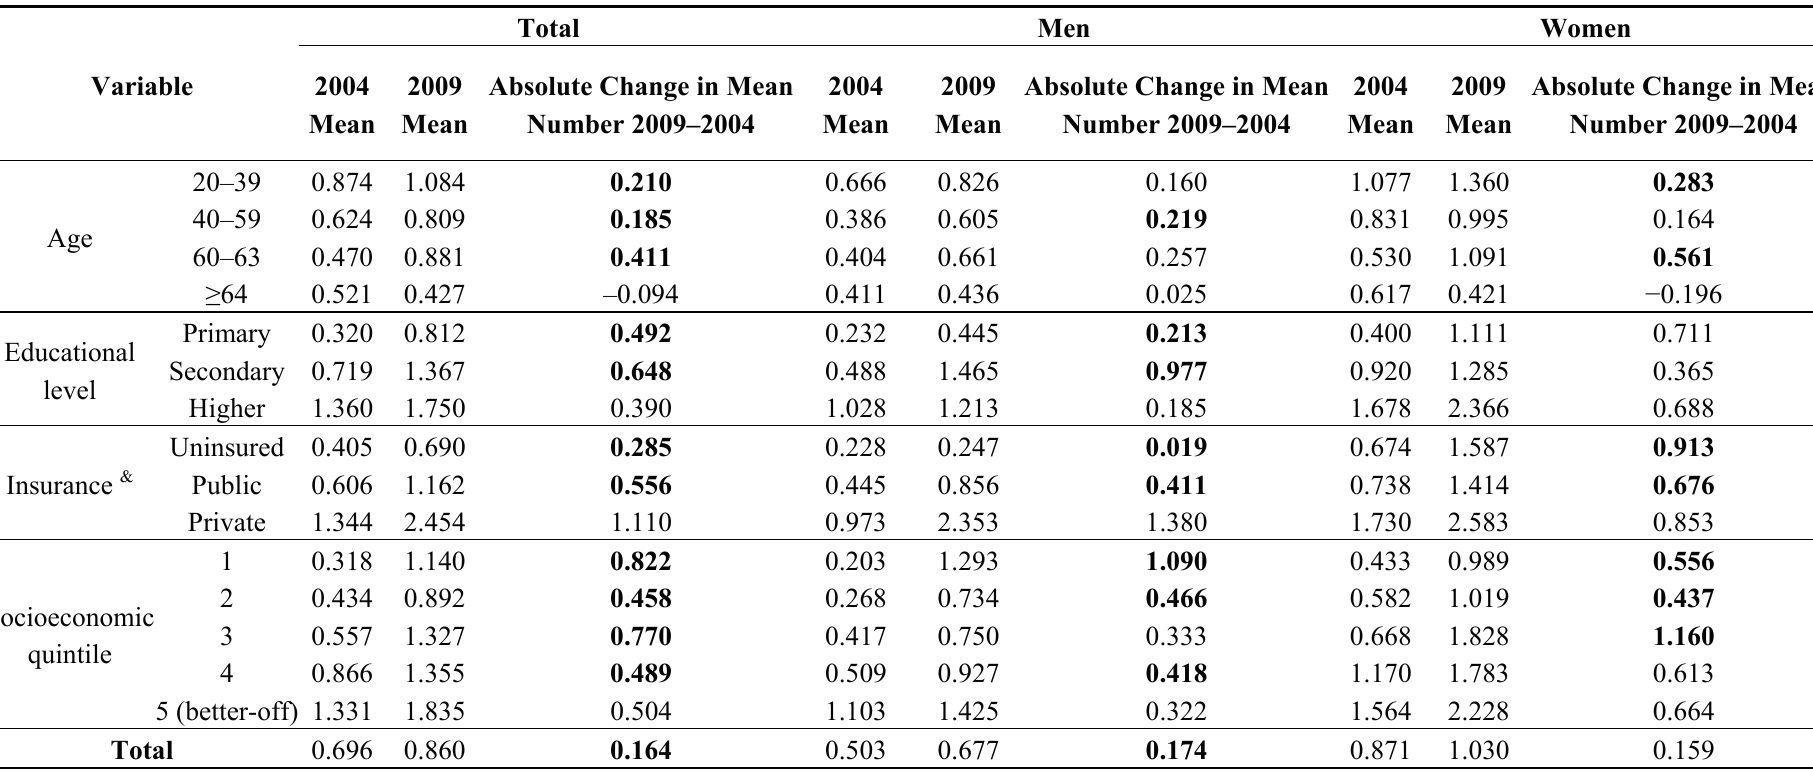
Table 3. Distribution of the mean and absolute changes in the mean number of dentist visits by socio-demographic variables. People aged ≥ 20 years. “Social Protection Survey”, Chile 2004 and